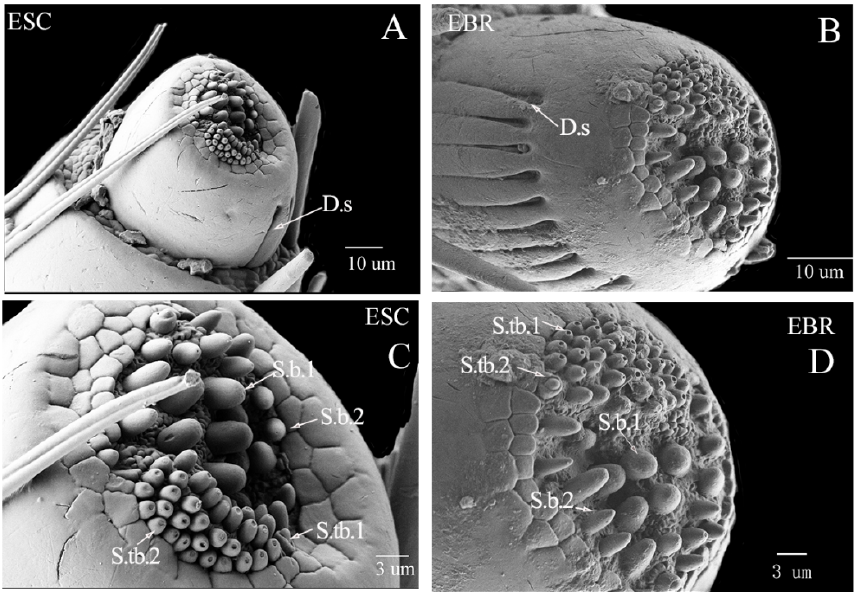
Figure 3. Scanning electron micrographs showing the first section of maxillary palpi of Eucryptor- rhynchus scrobiculatus (ESC) females and E. brandti (EBR) females. ( A , C ) the first section of maxillary palpi of E. scrobiculatus ; ( B , D ) the first section of maxillary palpi of E. brandti. Ds, digitiform sensilla; S.b.1-2, sensilla basiconica; S.tb.1-2, sensilla twig basiconica.